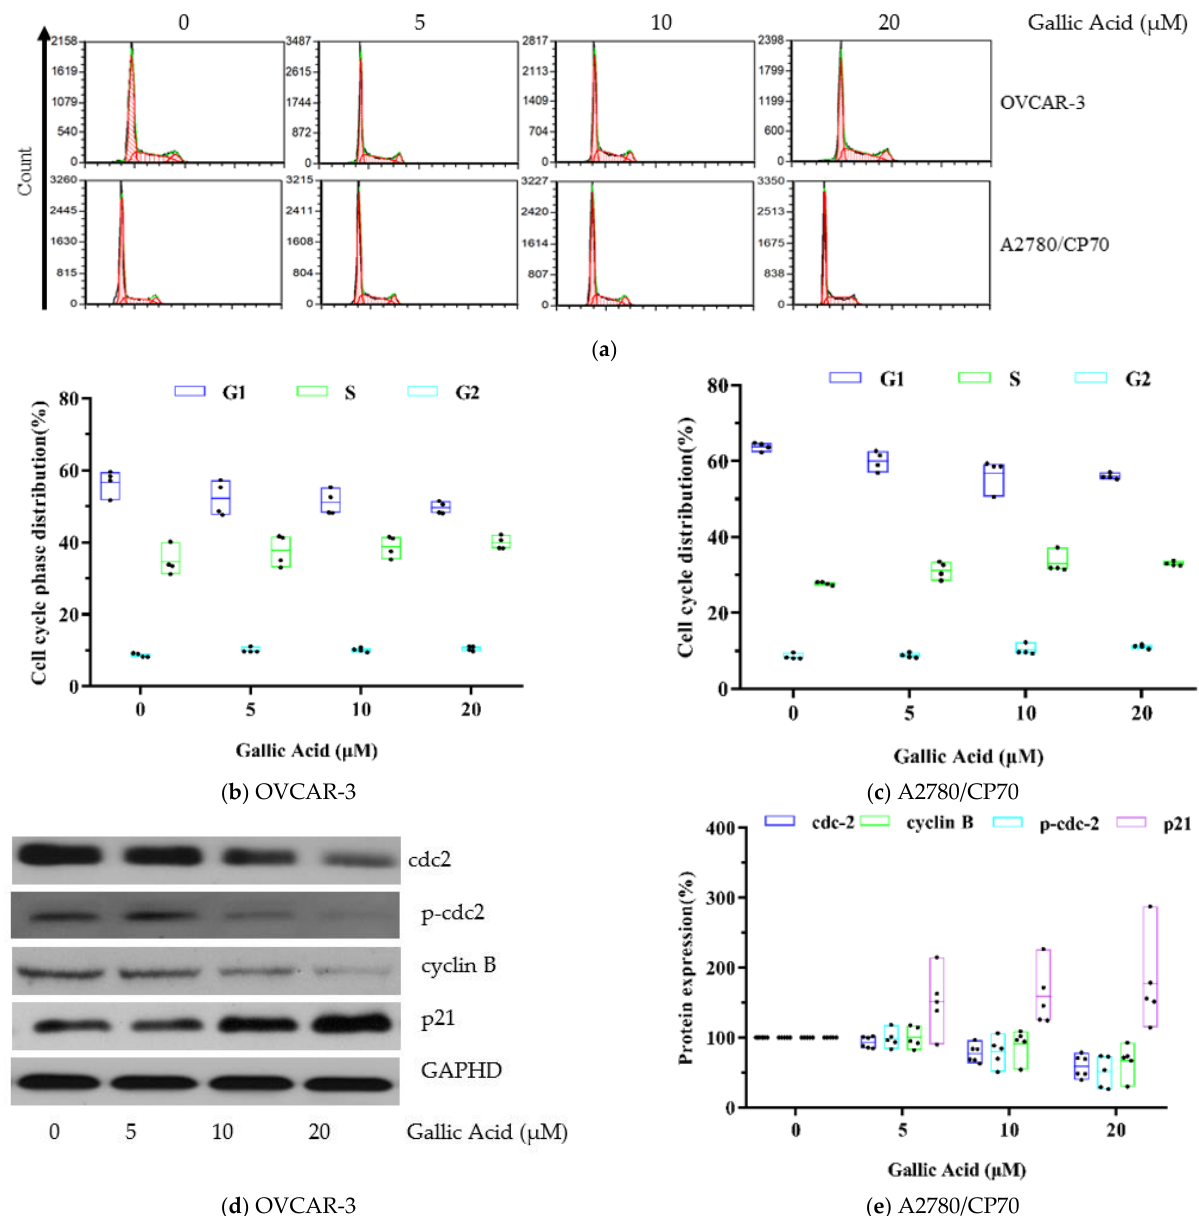
Figure 4. GA promotes phase arrest in OC cell lines. ( a ) Flow cytometry image. ( b ) GA stimulated larger population of cells at the S and G2 phase in OVCAR-3 cells. ( c ) GA stimulated larger population of cells at the S and G2 phase in A2780/CP70 cells. ( d ) Western blot image for OVCAR-3. ( e ) Protein expression quantization of cell cycle-related proteins for OVCAR-3.